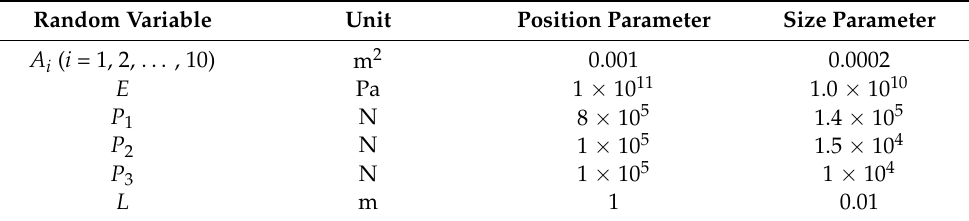
Figure 9. The 10-truss girder in Example 3. Table 5. Statistical parameters for Example 3.